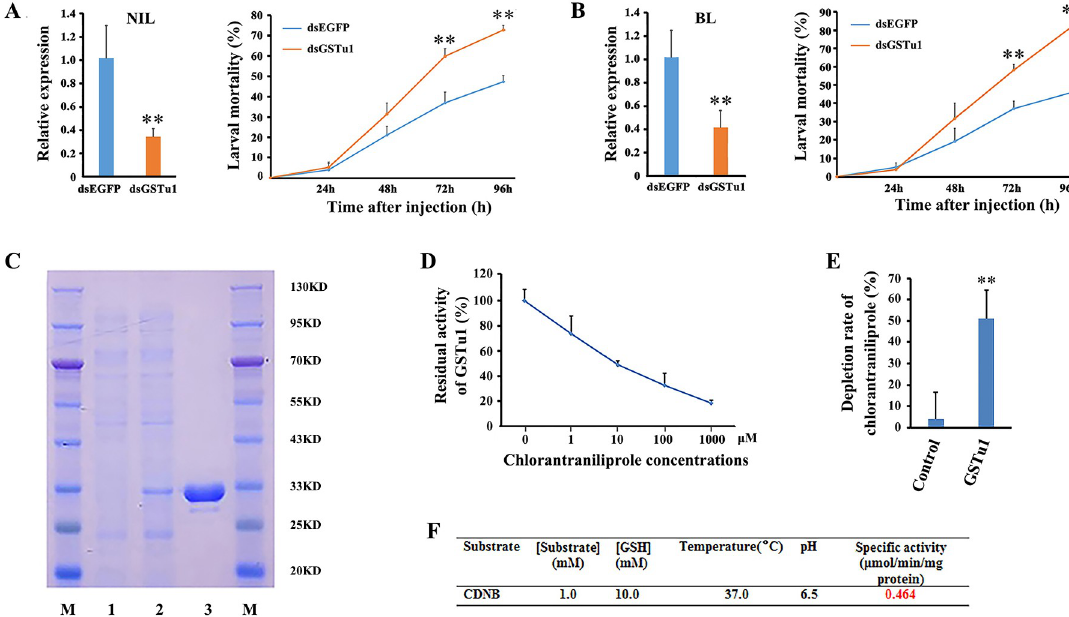
Fig 3. Functional analysis of GSTu1 in chlorantraniliprole resistance. RNAi-mediated knockdown of GSTu1 reduced the resistance of P . xylostella to chlorantraniliprole in NIL (A) and BL(B). C: Expression and purification of GSTu1 in the E . coli system (M: protein marker; lane 1: negative control; lane 2: total soluble proteins; lane 3: purified proteins). D: Enzyme kinetics of GSTu1 with a series of ascending chlorantraniliprole (0–1000 μ M) and fixed GSH. E: Depletion rate of chlorantraniliprole by recombinant GSTu1. F: The specific activity of purified GSTu1 toward CDNB. Asterisks indicate significant differences between the treatment and the corresponding control (Student’s t -test, � 0.01 < P < 0.05, �� P <